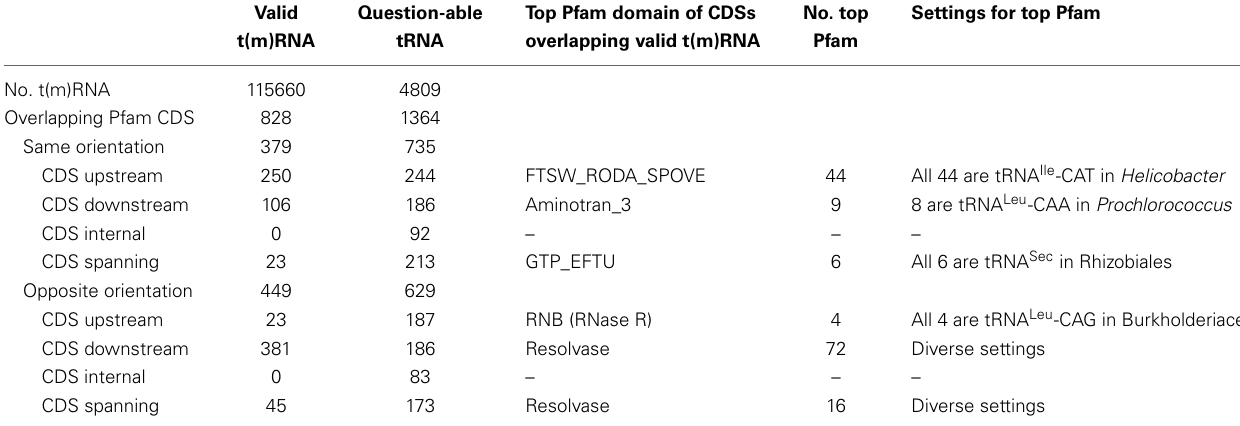
Table 4 | Functional protein CDSs that overlap t(m)RNA